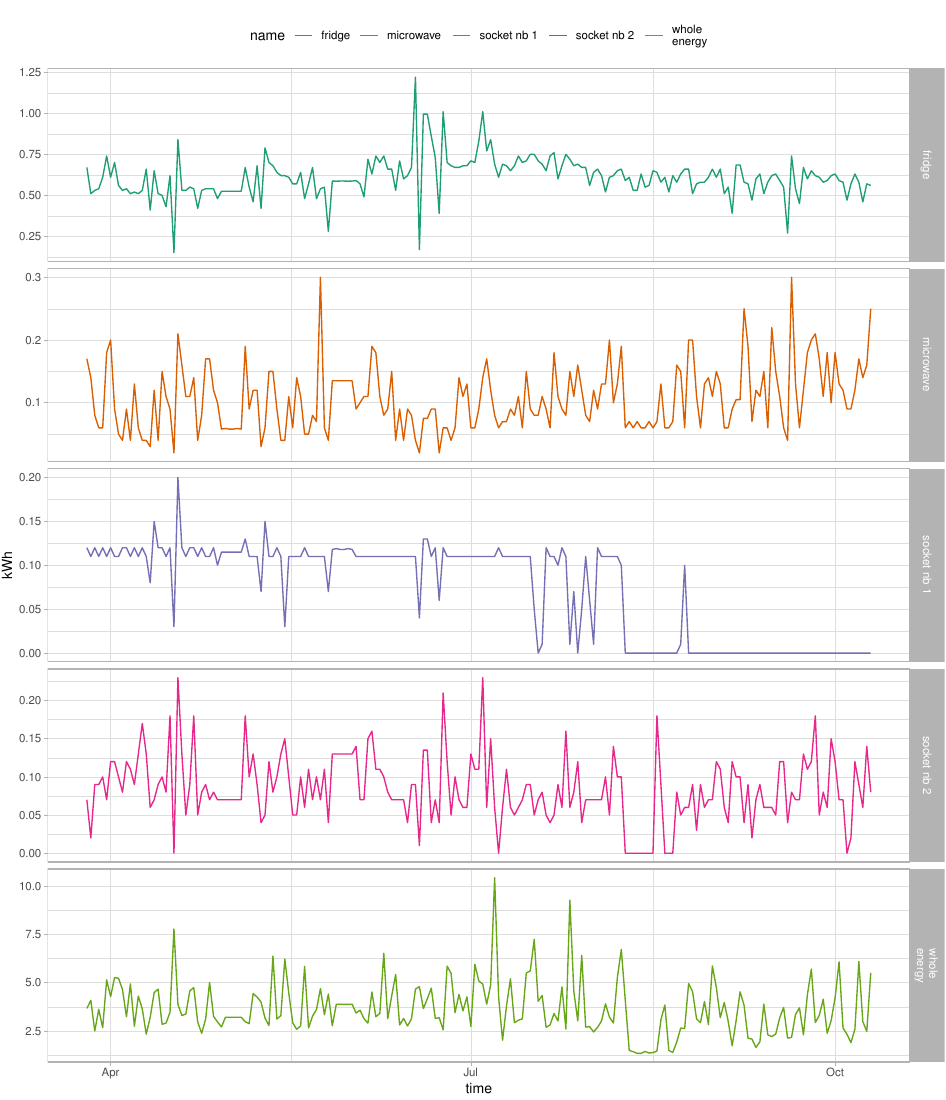
Figure 5. Time series for the whole energy consumption in location B and time series for the devices and attributes used in the decision tree (3)—microwave, fridge, socket number 1, socket number